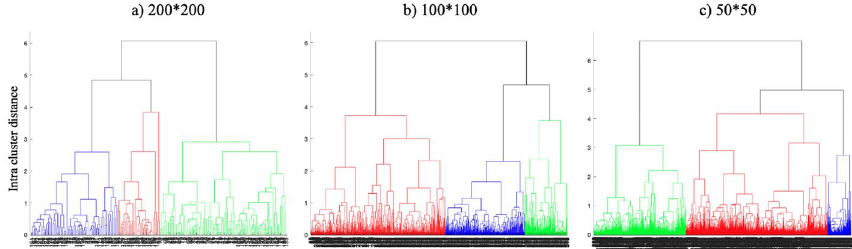
Fig. 4 Dendograms obtained using the Euclidean distance and the weighted method, varying different grid sizes: a 200x200, b 100 100, and c 50 × ×